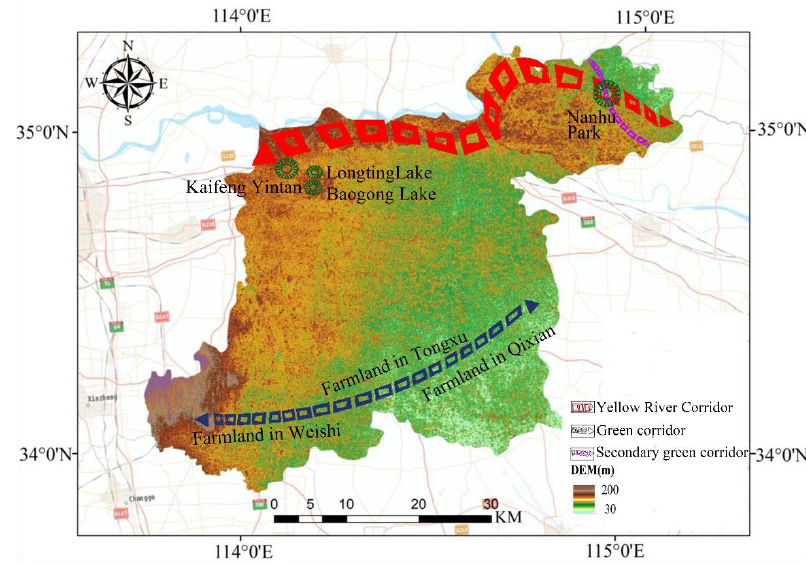
Figure 11. Source area of ecological ventilation corridors in Kaifeng.